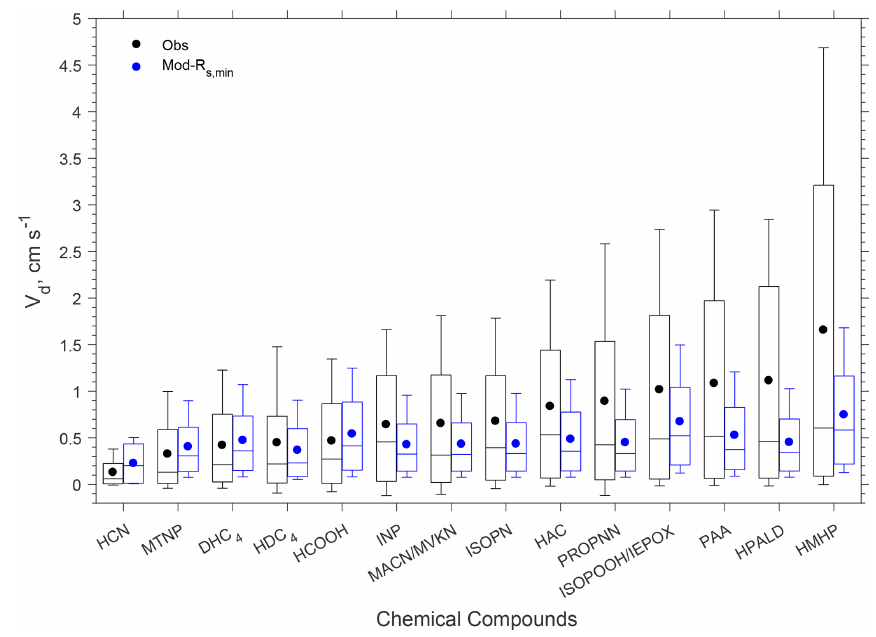
Figure 5. Box plot of observed and modeled hourly dry deposition velocities ( V d ) of oVOCs and HCN. In each box, the central mark is the median, the edges of the box are the 25th and 75th percentiles, and the whiskers extend to the 10th and 90th percentiles. The filled dots represent the arithmetical mean of all the data. “Mod- R s , min ” refers to a sensitivity test in which R s , min was reduced by 40%.